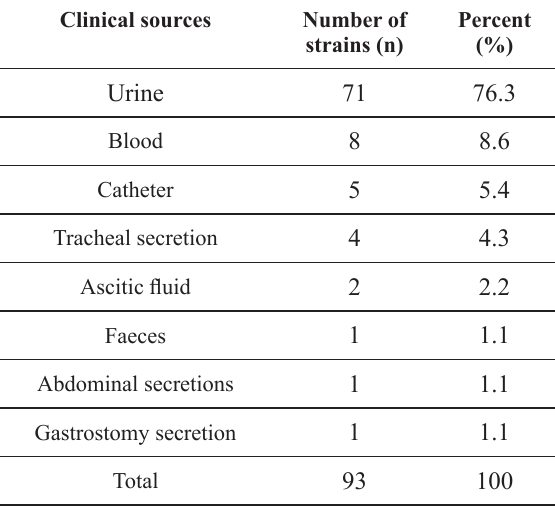
Number (n) and percent (%) of strains collected from different clinical sources. The isolates were collected mainly in urine